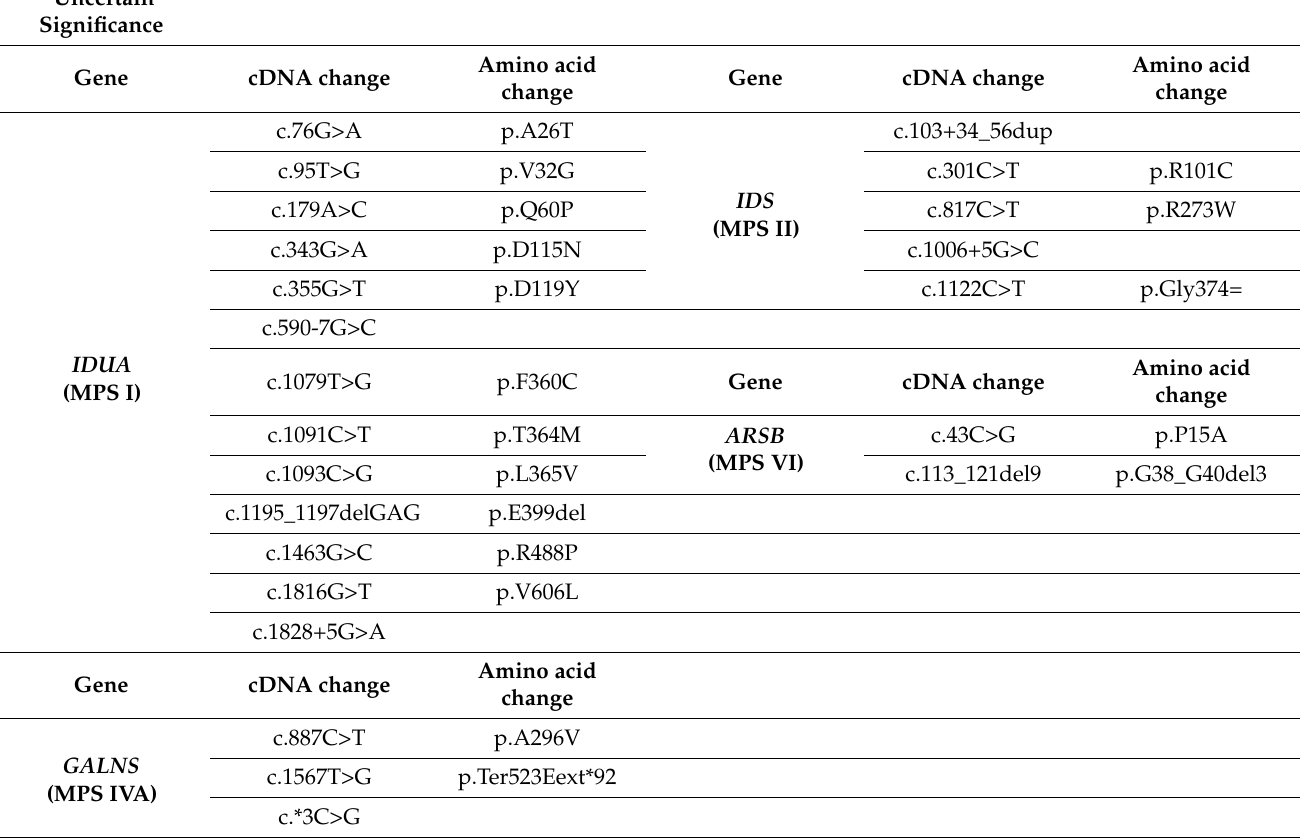
Table 3. Uncertain significance variants of MPS genes, i.e., IDUA , IDS , GALNS , and ARSB defined by the ACMG Classification.